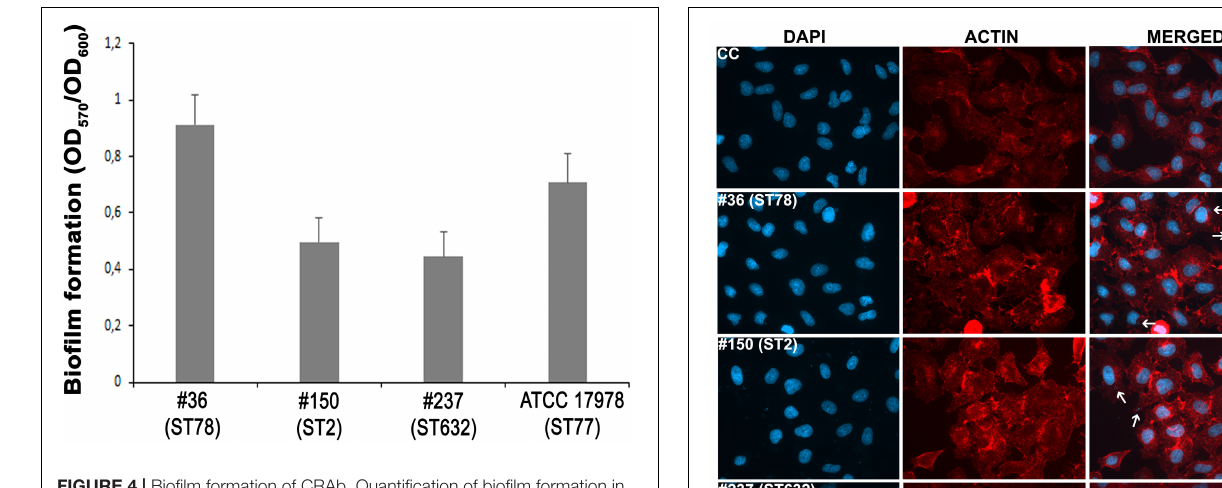
FIGURE 4 | Biofilm formation of CRAb. Quantification of biofilm formation in A. baumannii clinical isolates. Data are means ± standard deviation from at least three independent experiments, eight wells per strain ( P -value < 0.0001).